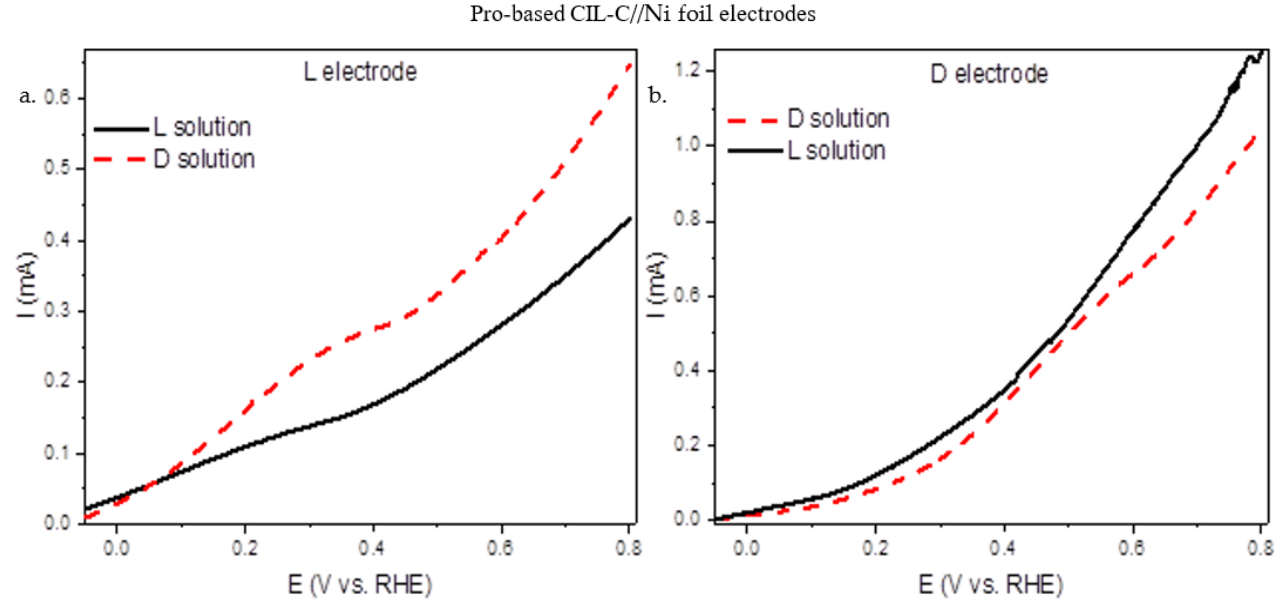
Figure 4. LSV (50 mV s − 1 ) of Pro-based CIL-C electrodes: ( a ) L-CIL(Pro)-C//Ni foil electrode and ( b ) D- CIL(Pro)-C//Ni foil electrode with R,R/S,S-TA. LSV measurements were taken at room temperature in 5 mM R,R- or S,S-TA (0.1 M Na 2 SO4 electrolyte solution).